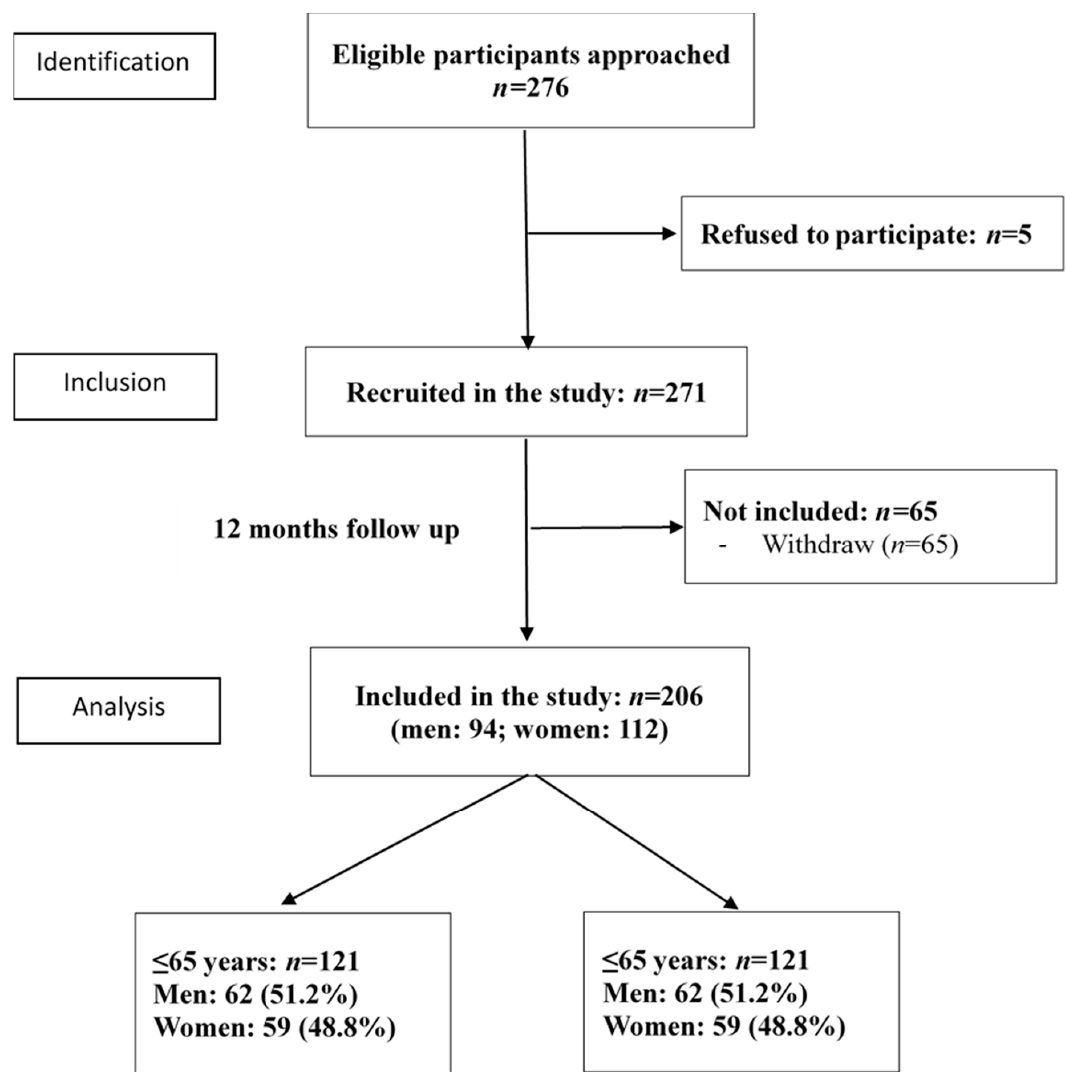
Figure 1. Recruiting flow chart. A total of 216 patients were recruited from an endocrinology outpatient clinic of a medical center. Eleven patients with missing data were excluded from this study. A total of 206 patients completed the baseline and 12-month follow-up measures. Among them, 121 younger patients (age ≤ 65 years) and 85 older patients (age >65 years) were analyzed separately in this study.